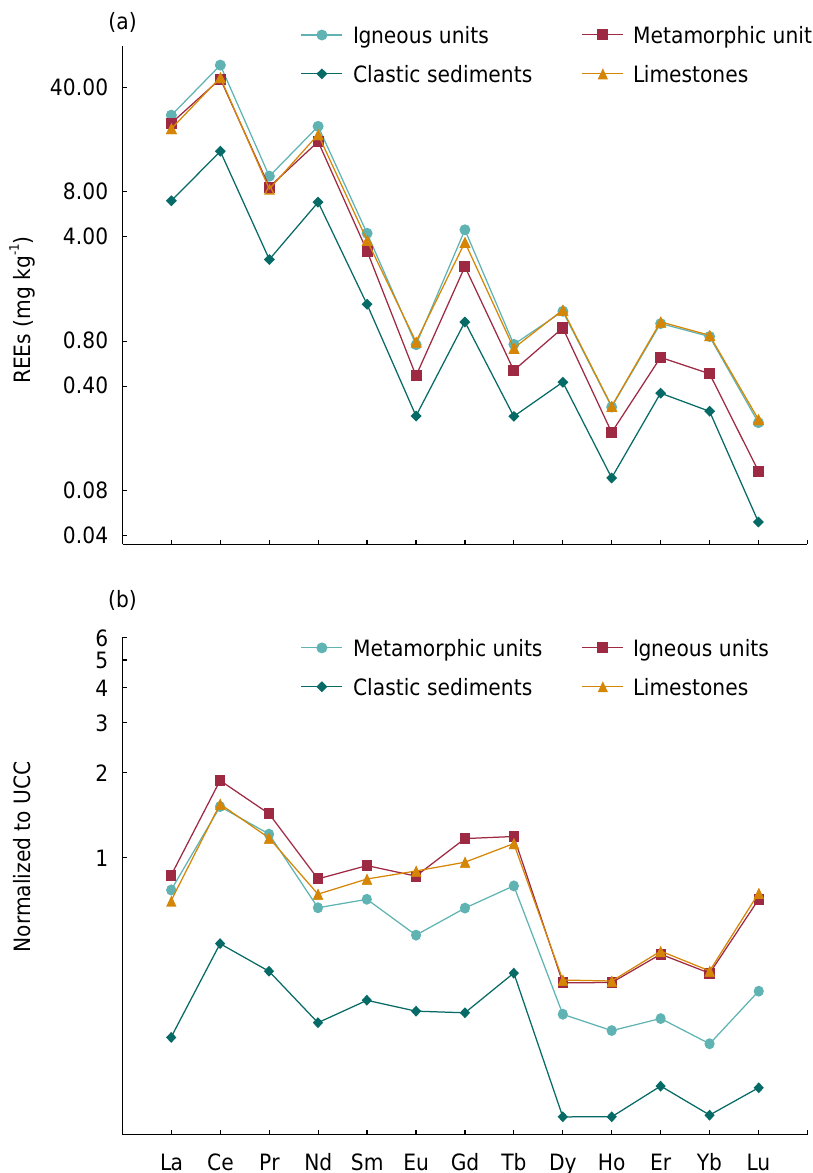
Figure 2. Rare earth elements in soils derived from different parent materials of the state of Rio Grande do Norte, Northeast Brazil. Non-normalized data (a). Data normalized to UCC